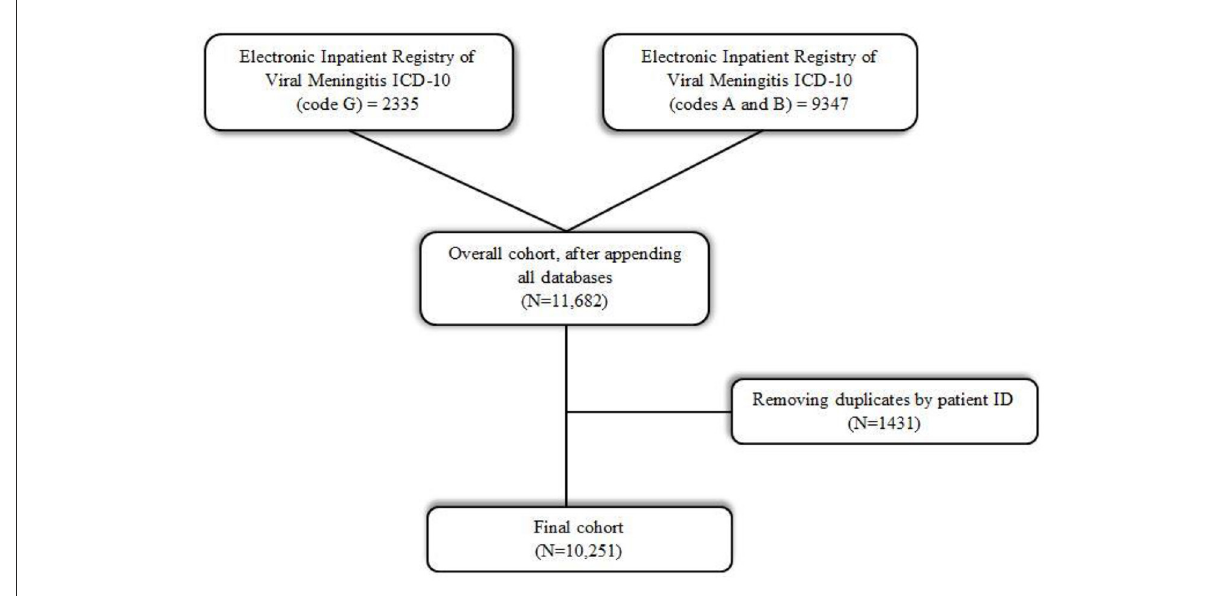
FIGURE1 The flowchart